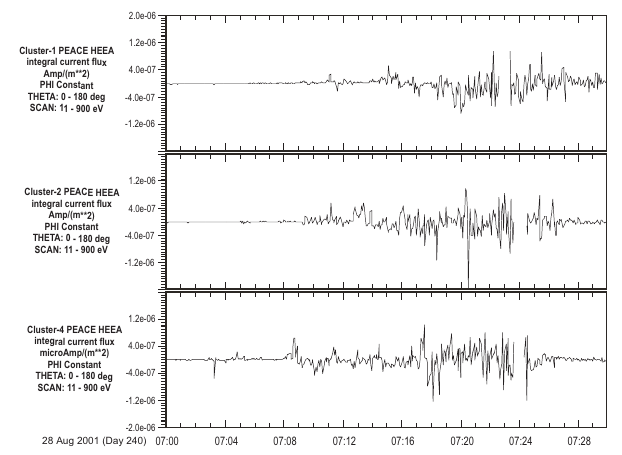
Fig. 12. Current densities determined from the C1, C2, and C4 PEACE electron data. The units are amps/m 2